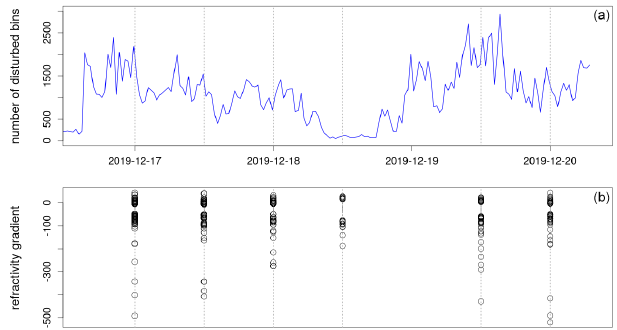
Figure 3. (a) Number of disturbed bins in the MHP data caused by EIS. (b) Refractivity gradients in the lowest 2.5km as computed from the Oberschleißheim radiosonde